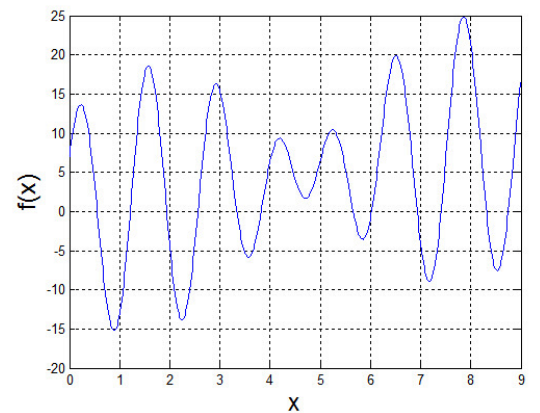
Figure 5. The graph of function F 1